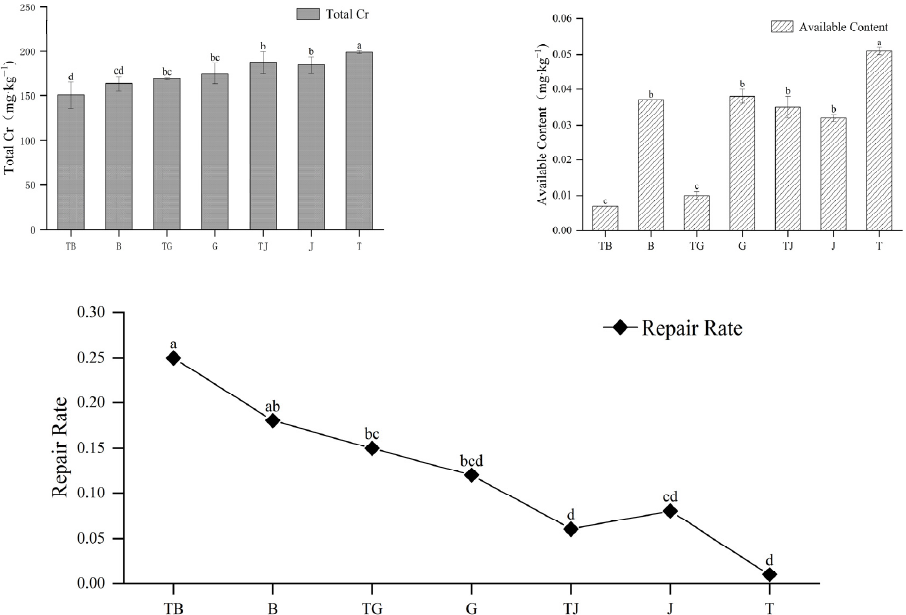
Figure 4. Changes in total Cr, available Cr and remediation rate in different treated soils. Note: different letters in the same column in the figure indicate that the difference between different treatments is significant ( p < 0.05). The data in the table are the mean ± standard deviation of 3